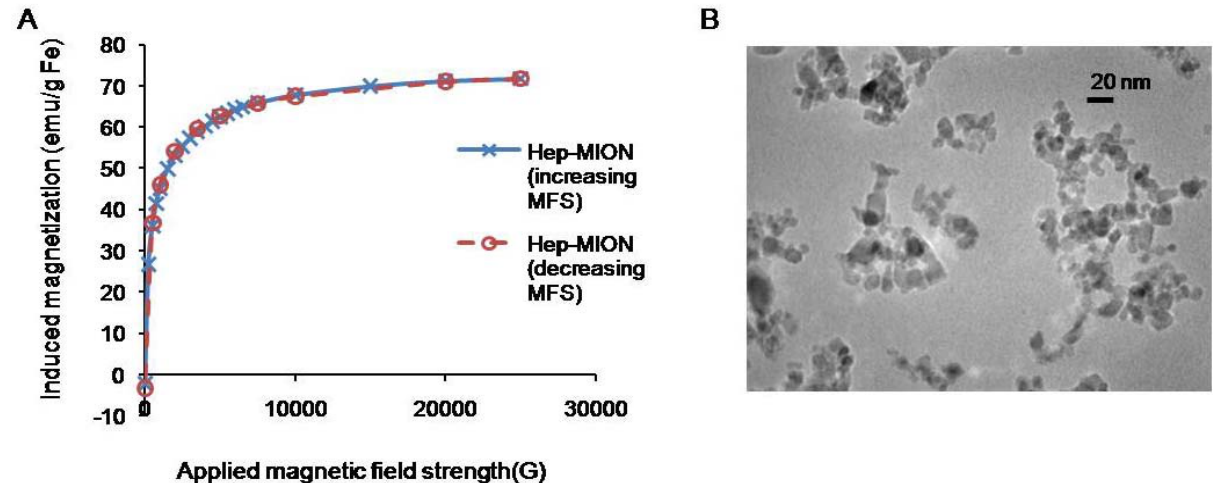
Figure 1. Physicochemical characterization of Hep-MION. (a) Magnetization of the Hep- MION was displayed as a function of applied magnetic field (Gauss) in a range between 0 and 30,000 G by using the SQUID at 25 ºC. The magnetization data from SQUID analysis were normalized by Fe content with the unit of emu per gram of Fe. The magnetization curve of the Hep-MION under increasing magnetic field (MFS) overlapped with the demagnetization curve under decreasing magnetic field, consistent with the expected superparamagnetic properties of Hep-MION. (b) Transmission electron microscopic images were captured at an accelerated voltage of 300 kV. Scale bar on the image is 20